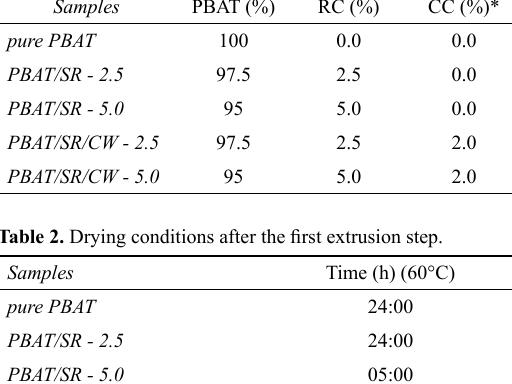
Table 1. Compositions of PBAT, sugar cane residue and carnauba wax used for producing biodegradable mulch films. Samples